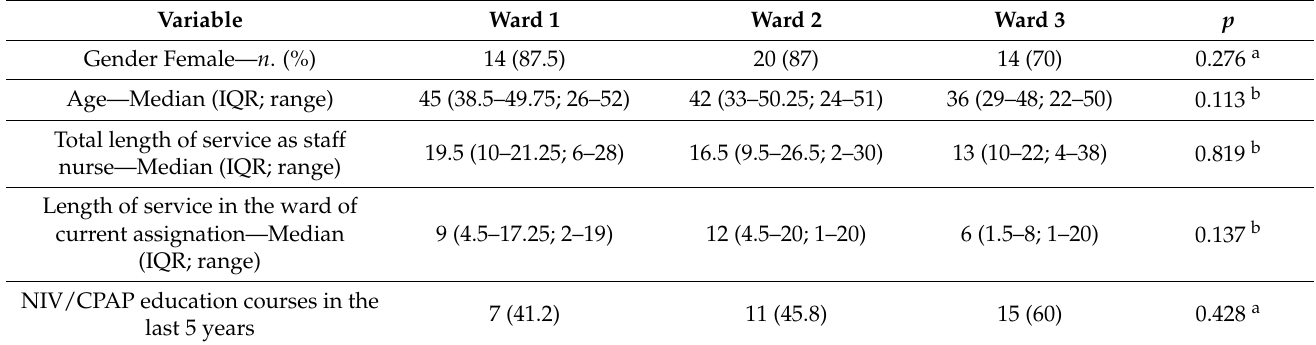
Table 1. Demographical characteristic of the respondents by the ward of current assignation.